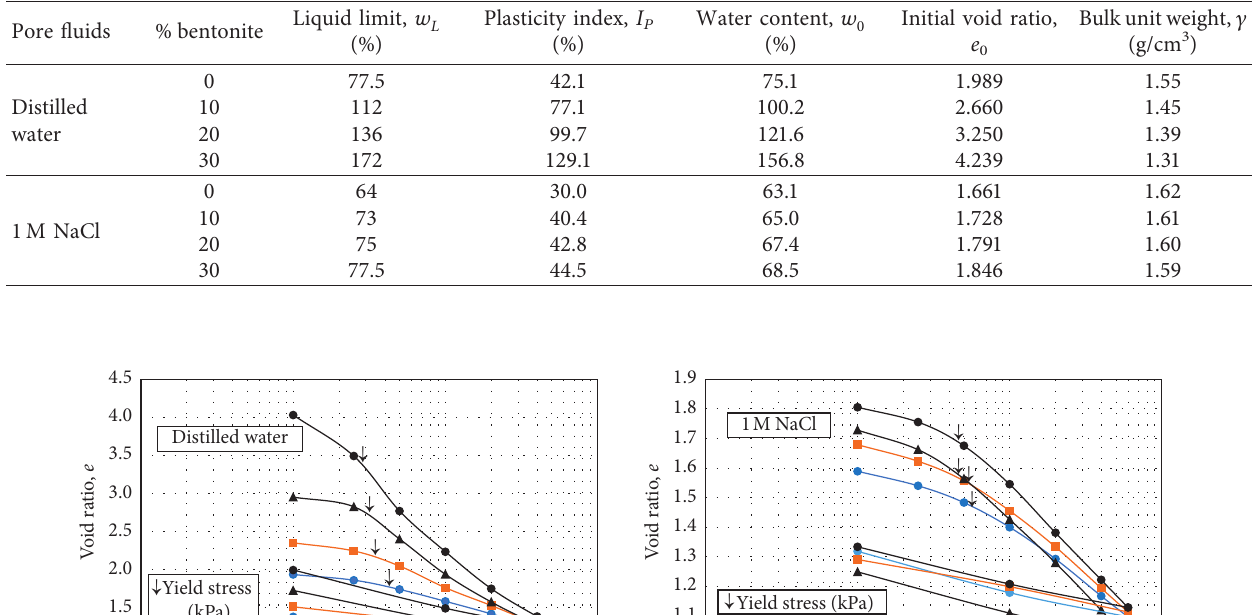
Table 2: Some physical properties of testing